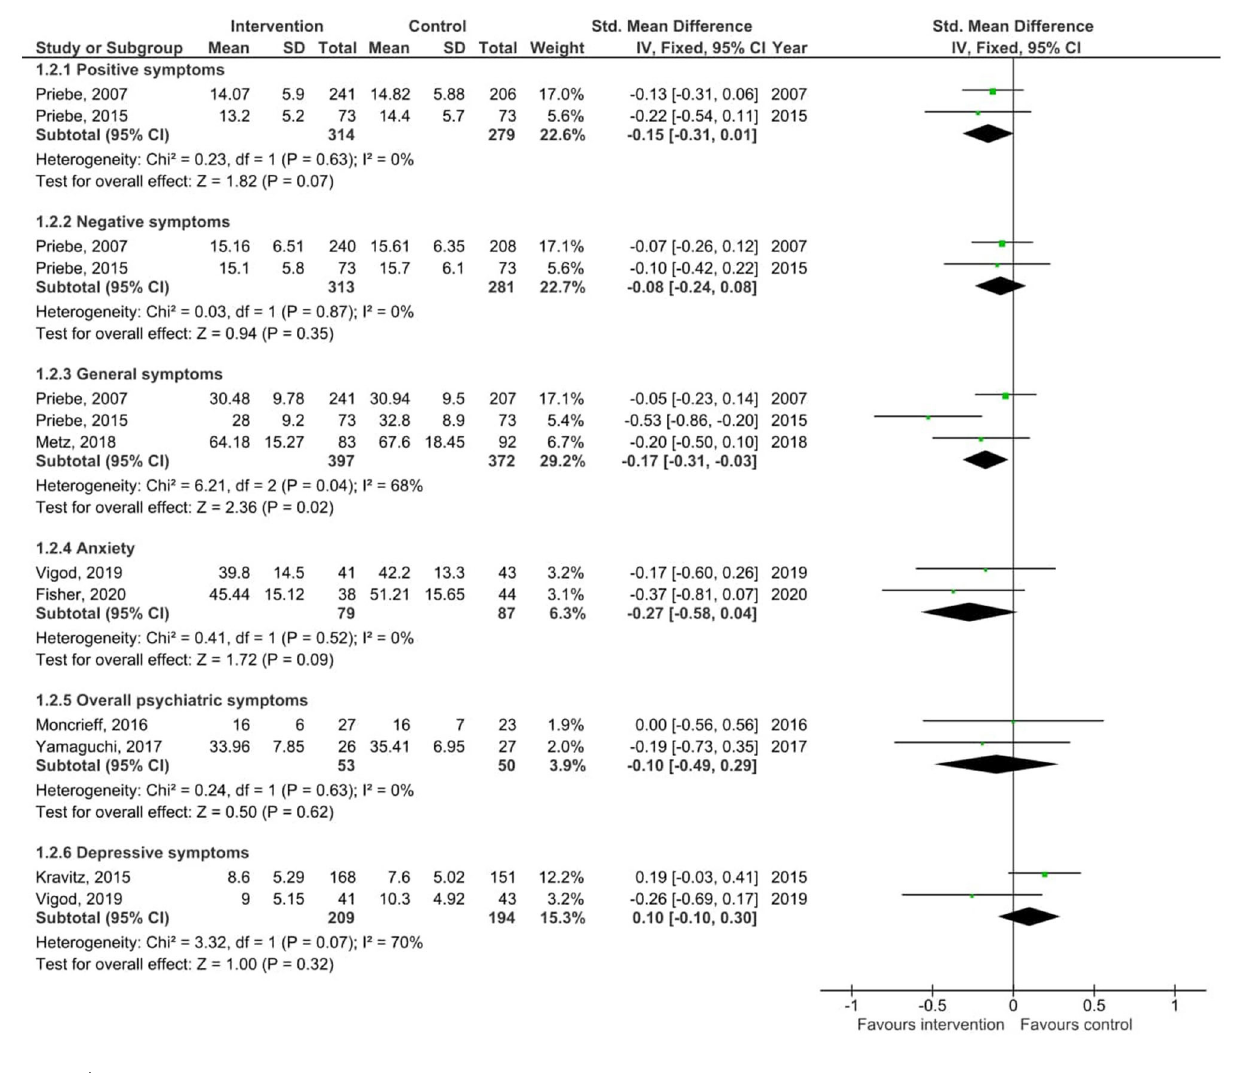
Variation across trials due to heterogeneity was not present (Chi 2 = 0.01, p = 0.93, I 2 = 0%). Subgroup analysis for the primary outcomes showed no significant differences, which are included in the Supplementary Materials